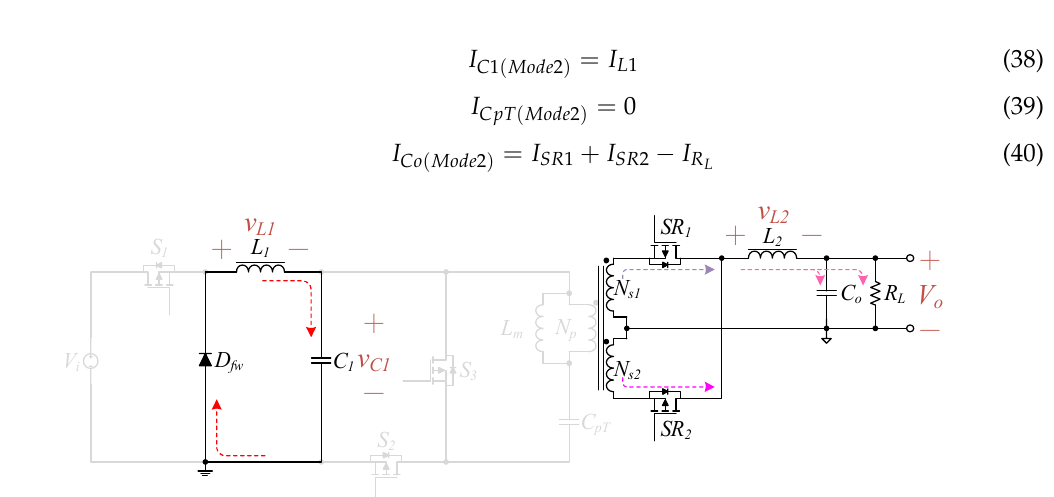
Figure 8. The switches S 1 , S 2 and S 3 are in the turned-off state.